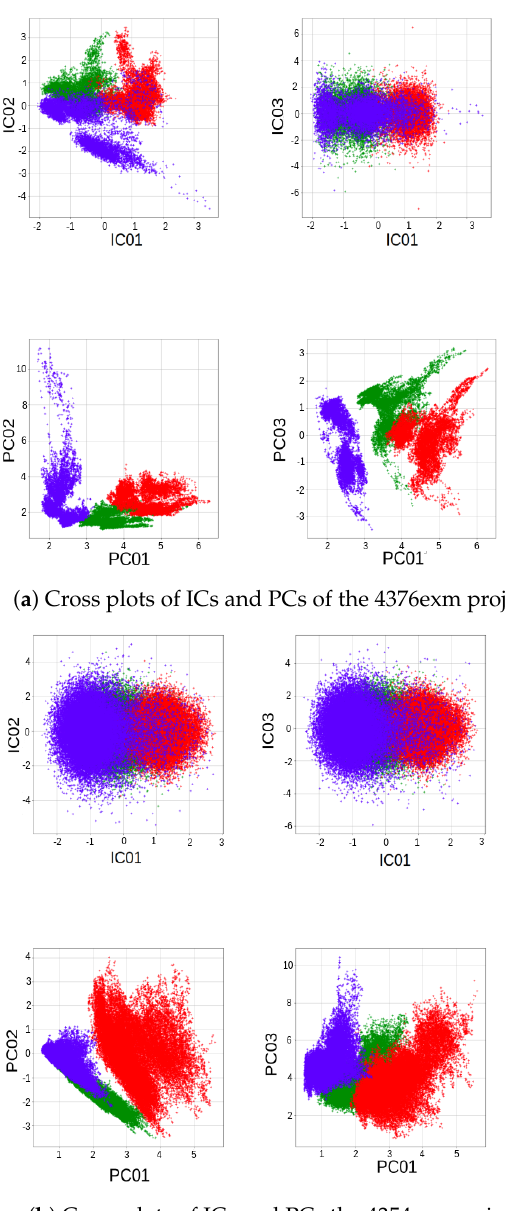
Figure 5. Cross plots of the first, second, and third independent and principal components of the 4376exm and 4354pgs